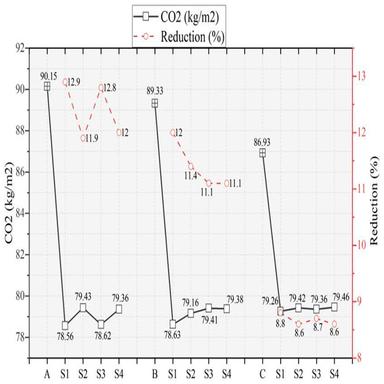
The comparison of the annual carbon emissions and reduction percentages of the existing façade finishes and their proposed solutions.